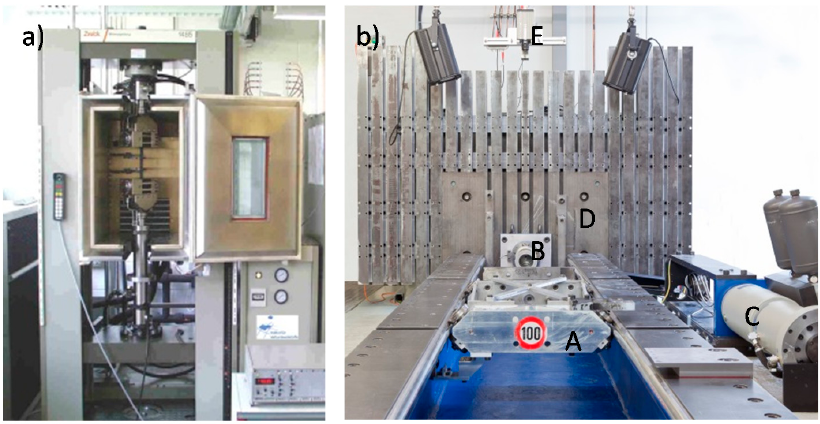
Figure3. Universal testing machine ( a ) Quasi-static tests set-up ( b ) Catapult crash facility used for Figure 3. Universal testing machine ( a ) Quasi-static tests set-up; ( b ) Catapult crash facility used for dynamic tests. dynamic